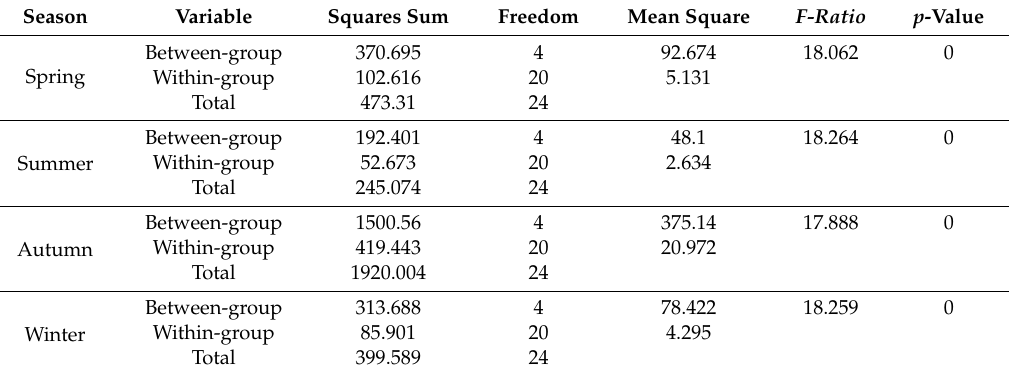
Table 5. Variance analysis